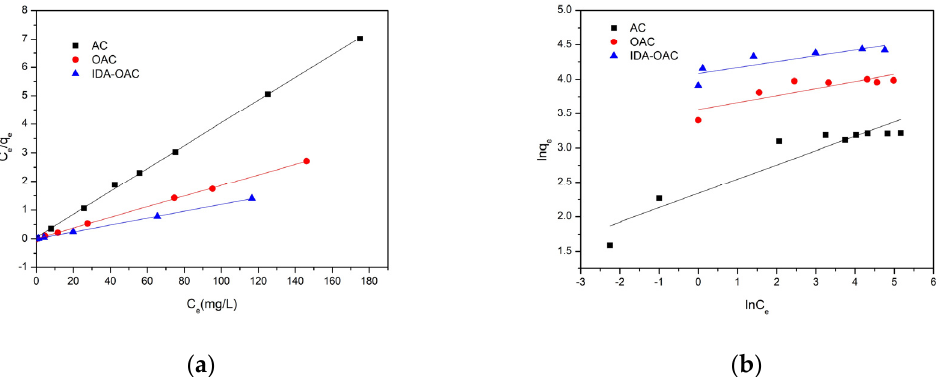
Figure 6. ( a ) Langmuir isotherm and ( b ) Freundlich isotherm model plots of AC, OAC, and IDA-OAC